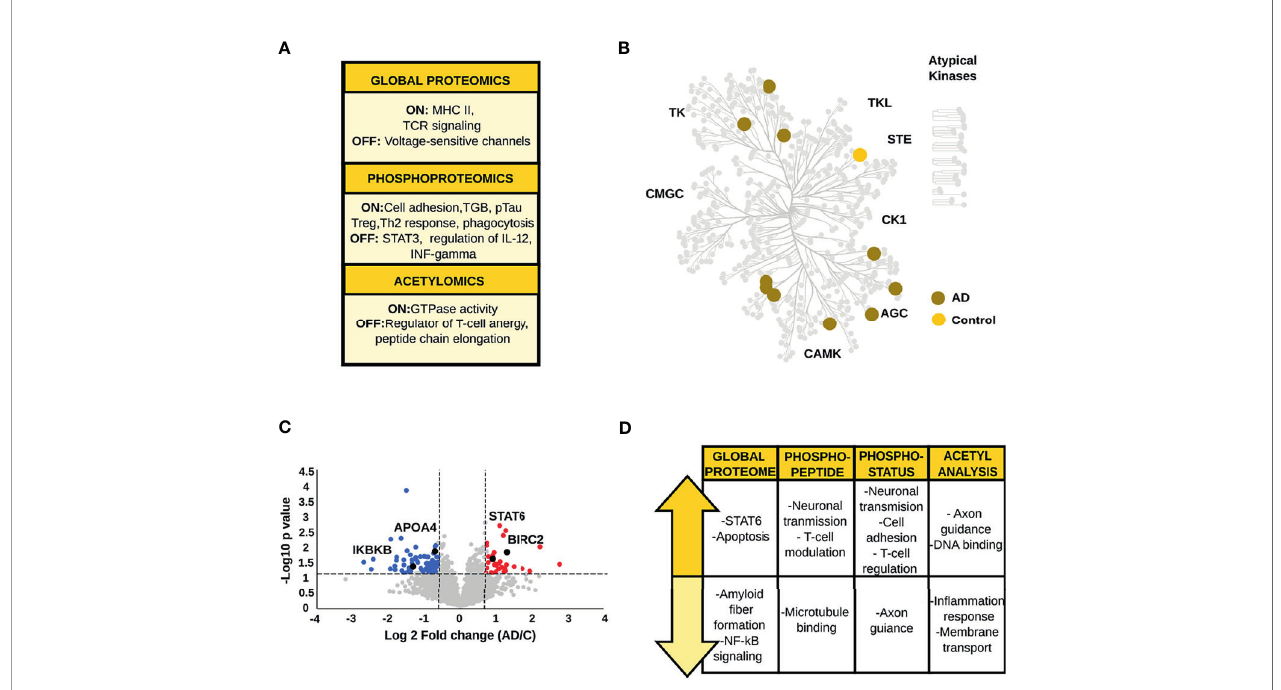
FIGURE 3 | (A) Biological processes emerging from the qualitative analysis of the CA1 region. (B) Kinome map of the CA1 region derived from the qualitative analysis of AD and control samples (C) Volcano plot of the global proteome data representing the variation in protein abundances between AD and control samples. (D) Main biological processes and pathways altered in the CA1